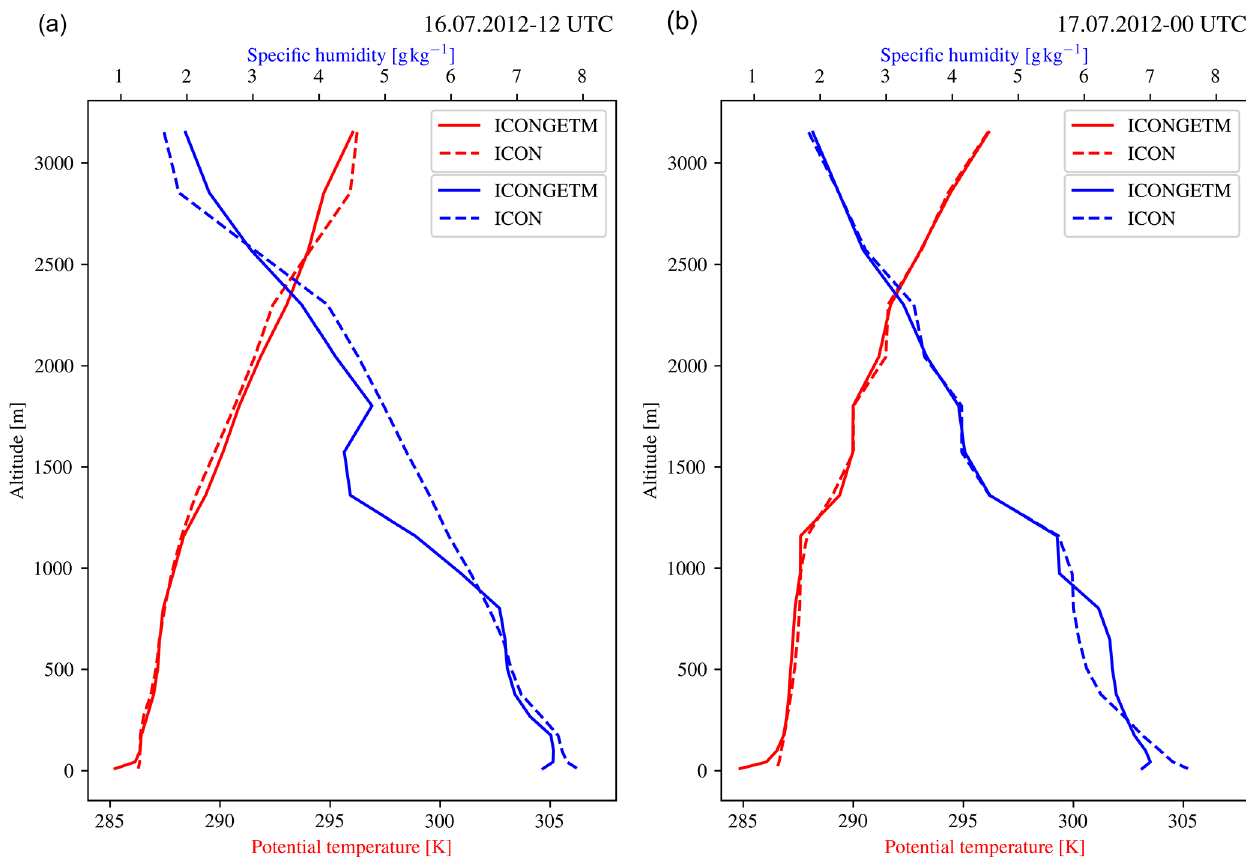
Figure 12. Atmospheric vertical profiles of potential temperature and specific humidity from the two-way coupled ICONGETM run and the uncoupled/one-way coupled ICON run for 16 (a) and 17 (b) July 2012 at 12:00 and 00:00UTC, respectively. The profiles are obtained south-east of the island of Öland; see black star in Fig.